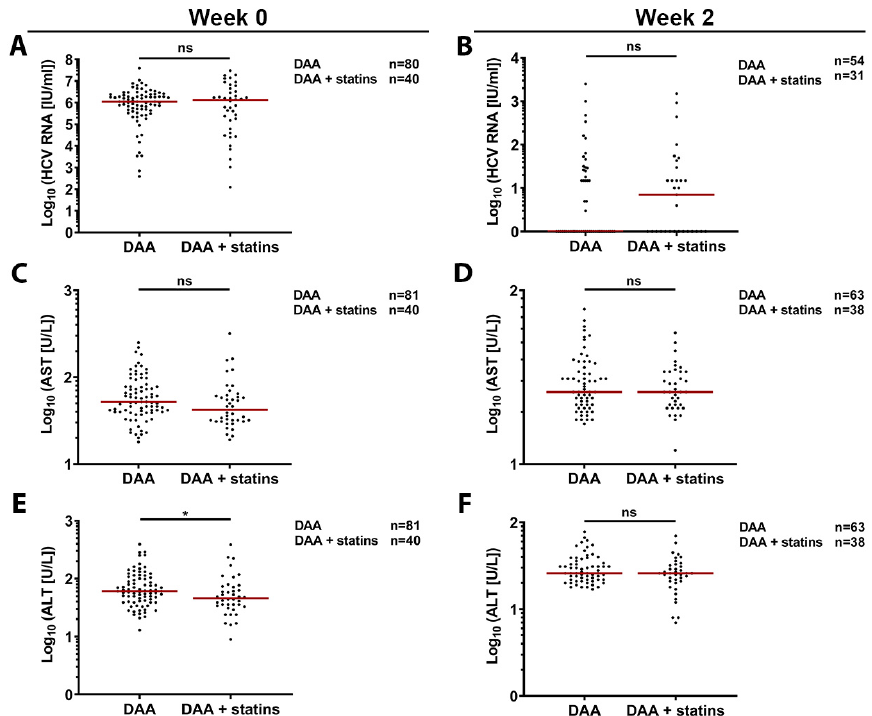
Figure 6. Mildly decreased aspartate aminotransferase (AST) and alanine aminotransferase (ALT) levels before HCV therapy in chronically infected patients taking statins. HCV RNA blood levels in patients following HCV direct-acting antiviral (DAA) therapy regimens in the presence or absence of statins ( A , B ). AST ( C , D ) and ALT ( E , F ) blood levels during HCV DAA treatment. Number of patients included in each analysis is shown in the legend and data points for each patient are represented as individual dots. For statistical analysis unpaired, two-tailed, no parametric Mann-Whitney test was performed. No significant (ns) p > 0.05; * p ≤ 0.05.